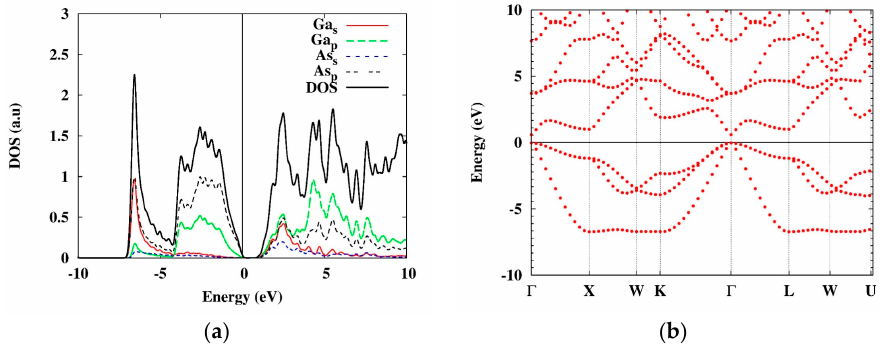
Figure 2. The orbital DOS ( a ) and the band structure ( b ) of bulk GaAs obtained with PBE approximation. The band gap is 0.595 eV.